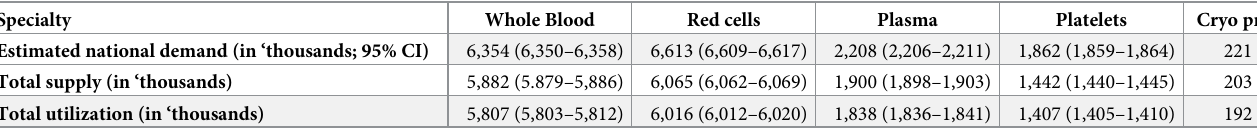
Table 5. Current demand, supply and utilization of whole blood and components (units).